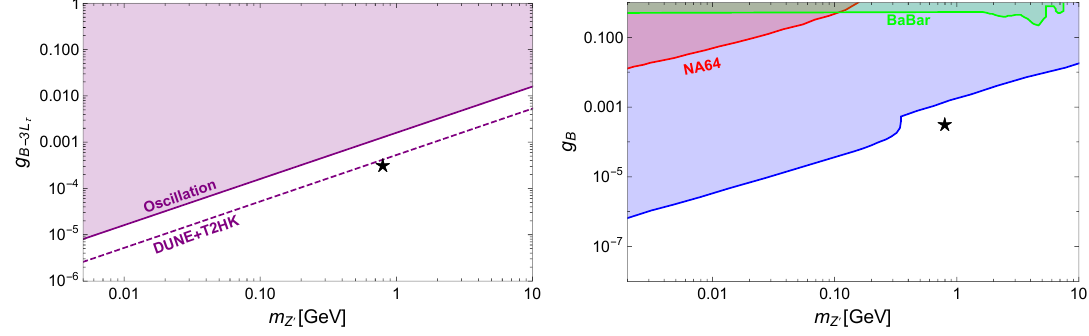
Figure 6 . Constraints on m Z 0 and g B − 3 L from oscillation experiments, denoted by the solid τ line and shaded region above it, along with projected sensitivities of T2K and DUNE (left panel, adapted from [142]) and on m Z 0 and g B from NA64 [194] and BaBar [195], along with theoretical bounds from (see text) [196, 197] (right panel, adapted from [139]) along with our benchmark in table 1 denoted by the black